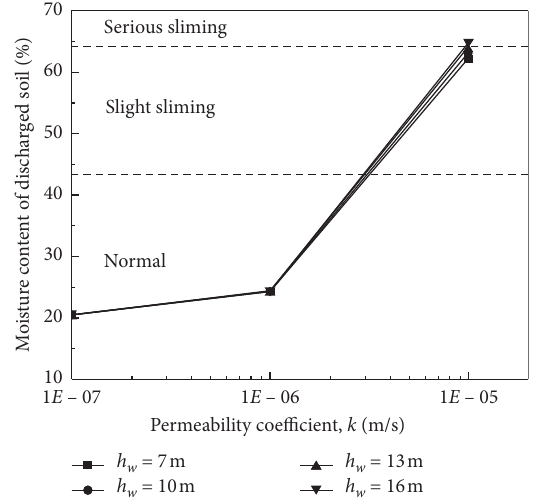
Figure 13: Influence of k on the moisture content of chamber soil when t � 4h/ring and α �